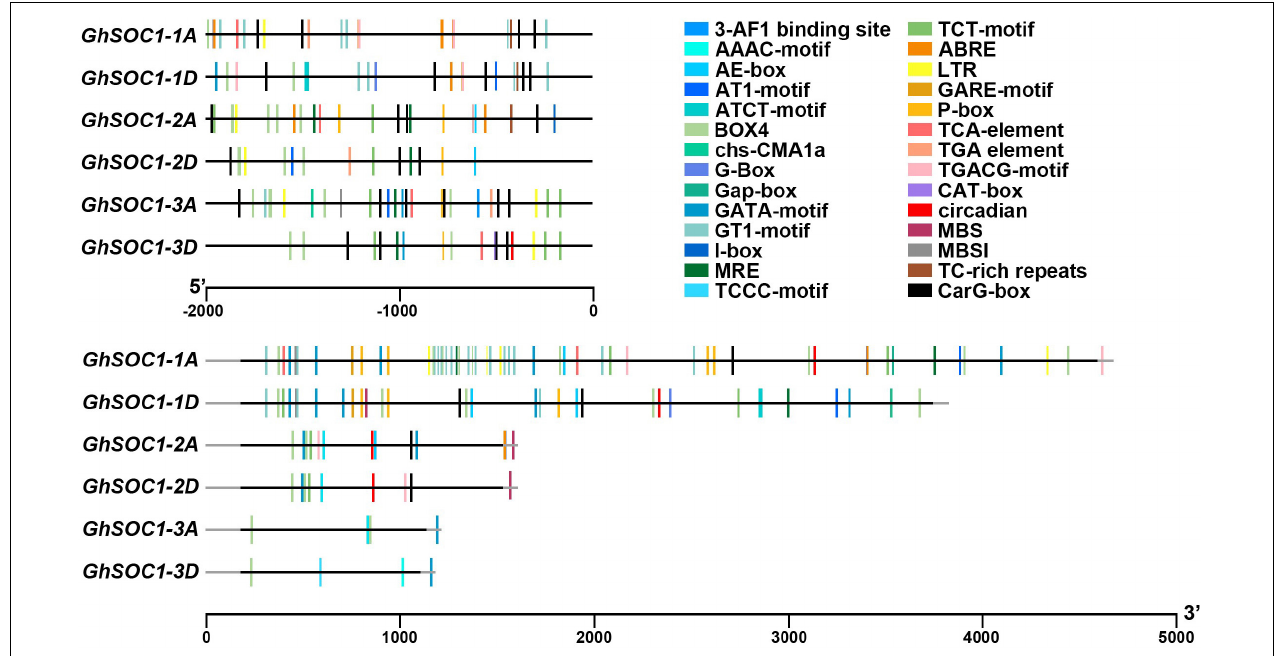
FIGURE 3 | Prediction of cis -acting elements in GhSOC1s genome. The coding region and non-coding region are presented in gray and black